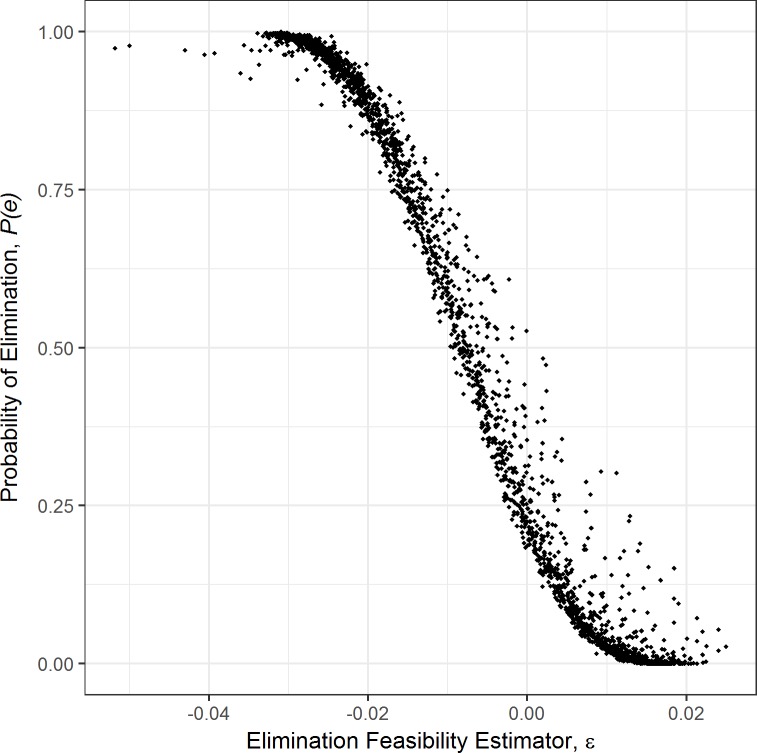
Correlation between mean ε and P(e).Correlation between mean ε and P(e) for each parameter set derived from 1,000 simulations of the stochastic model. The model-free elimination feasibility coefficient is a strong predictor of the model-predicted probability of extinction even in the presence of demographic stochasticity and observation noise (R2 = 0.94; probit-transformed P(e)).